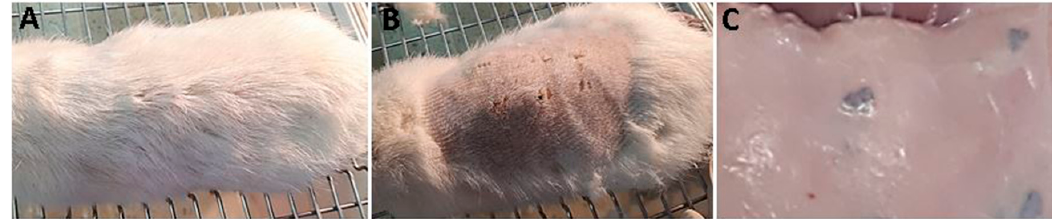
Figure 8. Zone of subdermal implantation in Wistar rats after 30, 60, and 90 days: ( A ) hair recovery, ( B ) absence of immune responses, and ( C ) subdermal implantation zones with samples encapsulated by scar tissue.